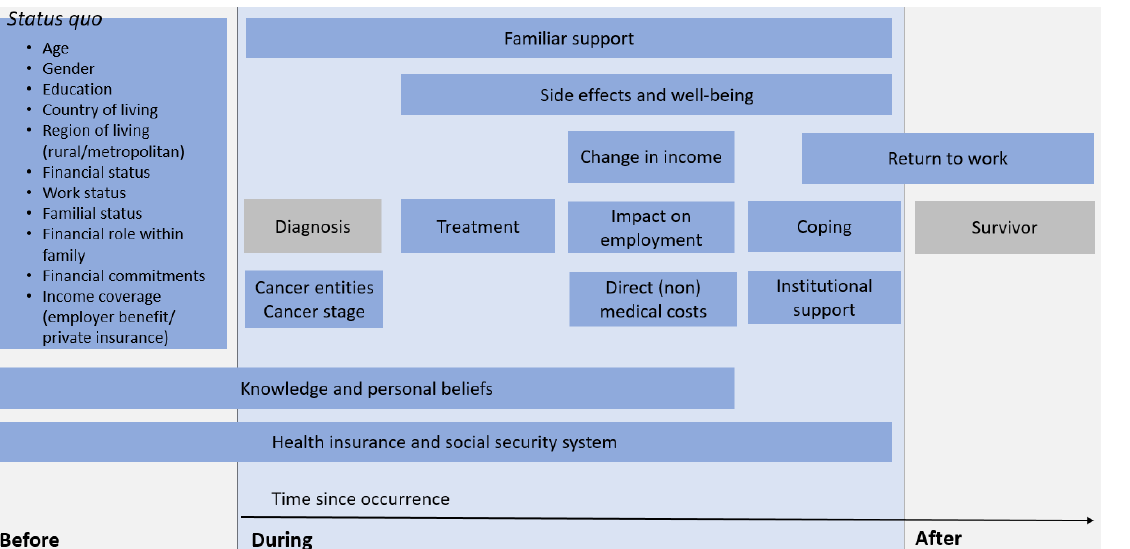
Figure 3. Identified categories of risk factors for financial distress. Categories which showed significant results in quanti- tative studies are coloured in darker blue. Prevalence of (sub)categories were counted on study level.